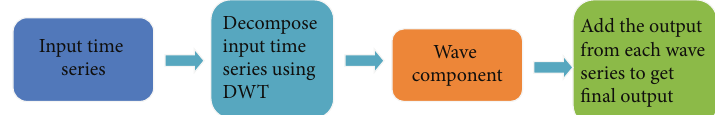
Figure 4: Flow chart of proposed discrete wavelet algorithm.